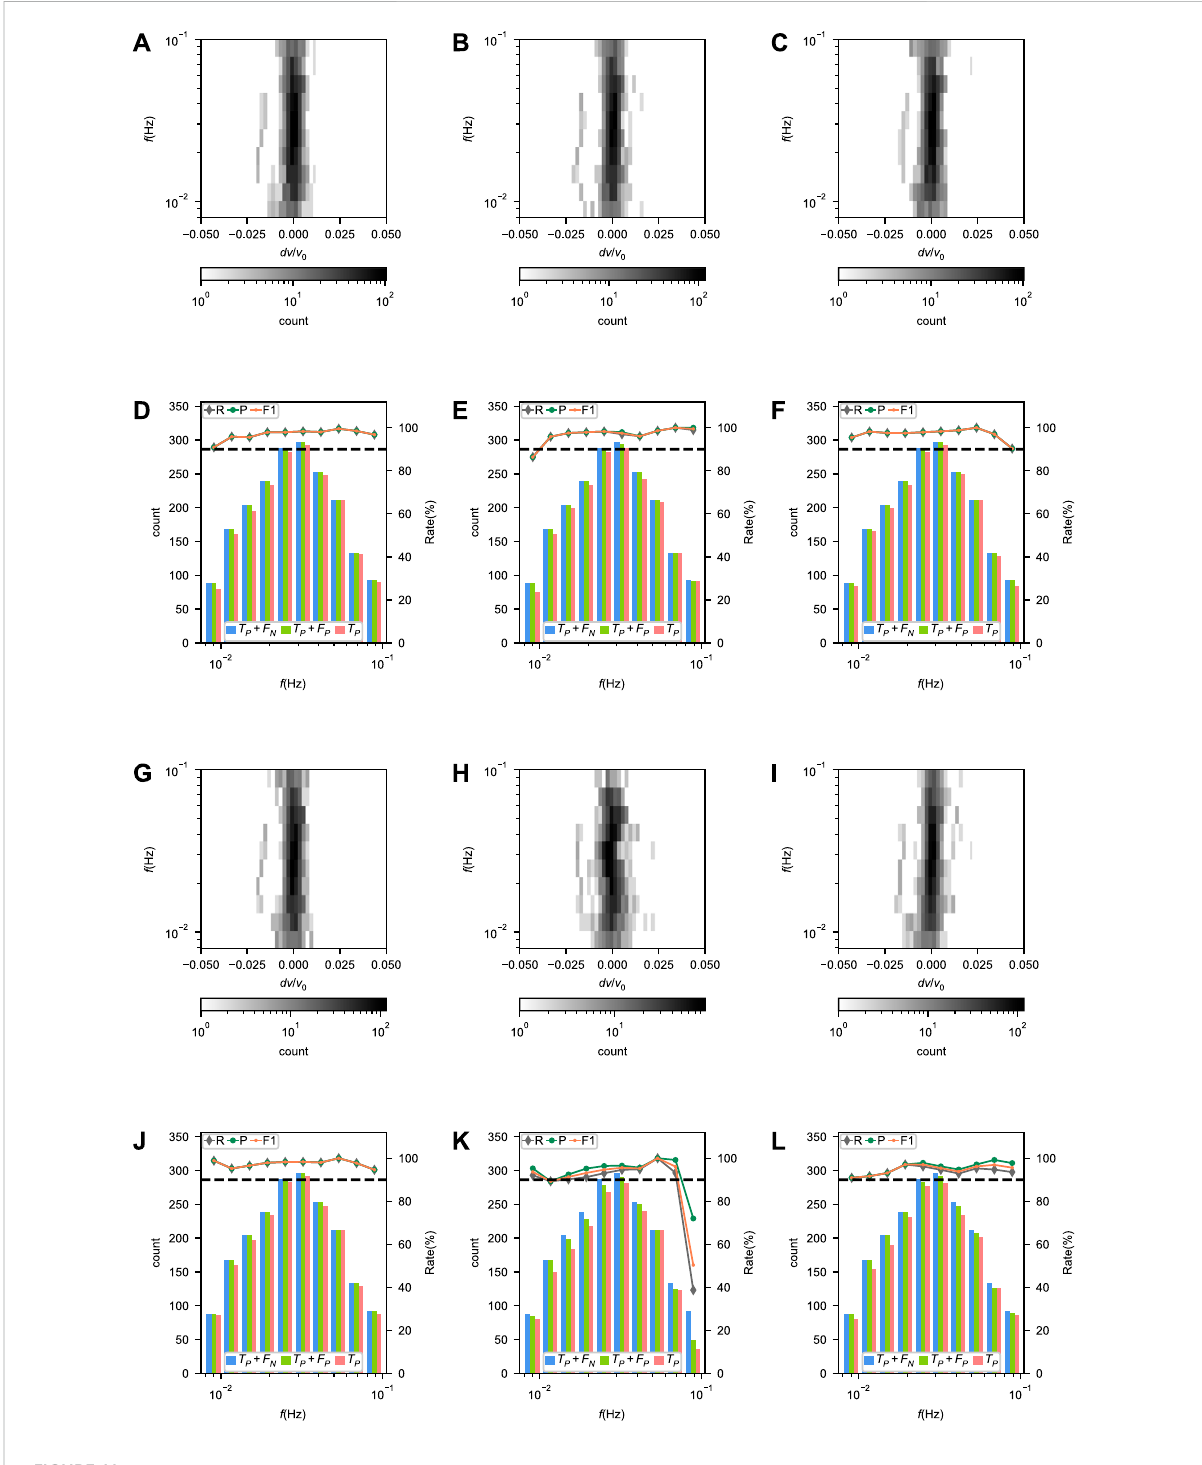
FIGURE 11 (A – C) and (G – I) Error distributions and (D – F) and (J – L) performances of Surf-Net (A, D) , Surf-Net_noDis (B,E) , Surf-Net_small (C,F) , Surf- Net_obs (G,J) , surf-Net_syn (H,K) and the conventional method (I,L) at different frequencies for the average picks in the observational test